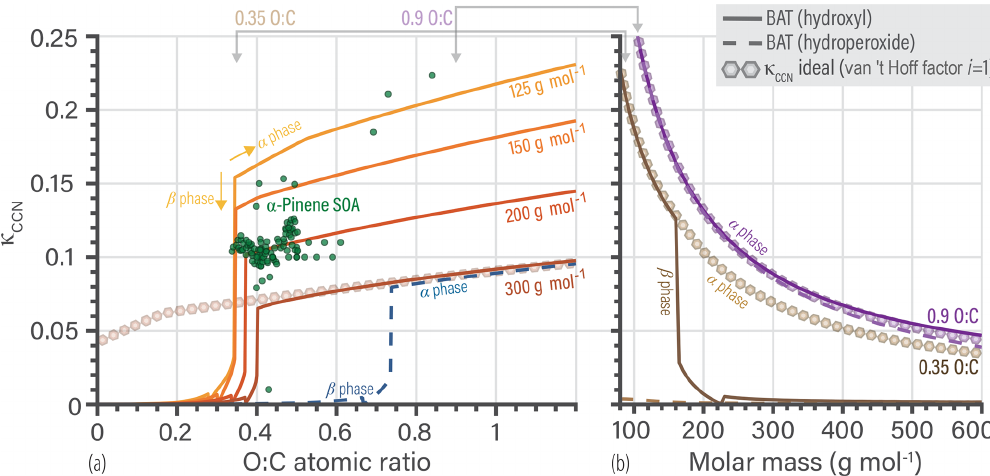
Figure 10. Comparison of κ CCN derived from α -pinene SOA measurements with those from BAT model simulations of CCN activation. The simulations assume a 100nm diameter equivalent volume of organic matter at the CCN activation point. The droplet surface tension is calculated as a volume-weighted mean; see Sect. 5.3. Shown are the predictions for two-component systems comprising water and a single organic. (a) BAT simulations and experimental data for κ CCN as a function of O : C. The data for α -pinene SOA is listed in the Supplement (Massoli et al., 2010; Poulain et al., 2010; Frosch et al., 2011; Kuwata et al., 2013; Rickards et al., 2013; Cain and Pandis, 2017; Wang et al., 2019). (b) The molar mass dependence of κ CCN for two cases at constant O : C of 0.35 or 0.9, showing ideal mixing as well as miscibility gap considerations with BAT in the O : C = 0.35 case. (a, b) BAT simulations based on the hydroxyl group parameter set are shown as solid curves, while the dashed curves show a BAT calculation using the hydroperoxide functional group parameters. The thick curves represent single-organic + water systems with the κ CCN of the β phase transitioning to the one based on the α phase at O : C ratios of 0.3–0.4. The hexagons show κ CCN for an organic component assuming ideal mixing with water (in panel a for M org = 300gmol − 1 ) and a van ’t Hoff factor of